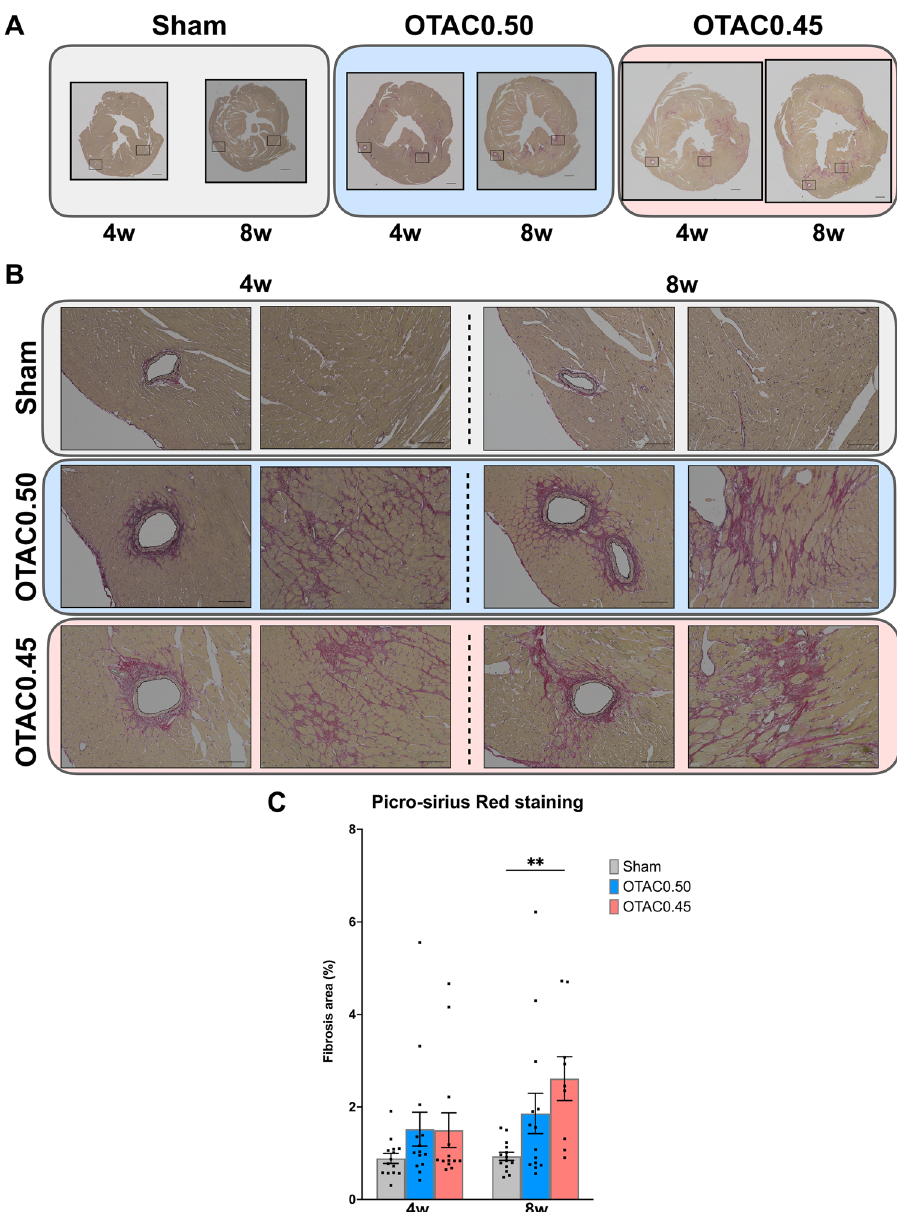
Figure 6. Histological analysis of left ventricular tissue showing graded cardiac fibrosis. Representative images of short-axis cardiac sections with Sirius-red staining in Sham and OTAC 4 and 8 weeks post procedures ( A, B ). ( A ) ×4 magnification of left ventricular at mid-ventricular sections. Scale = 500 µm. ( B ) Left: ×40 magnification of a representative area of perivascular fibrosis. Scale = 100 µm. ( B ) Right: ×40 magnification of a representative area of interstitial fibrosis. Scale = 100 µm. ( C ) Quantification of left ventricular fibrosis (% of the area of mid- ventricular sections) 4 and 8 weeks post procedures. Comparison among groups was performed by one-way ANOVA with Tukey’s post hoc tests; n = 9–14. ** P <